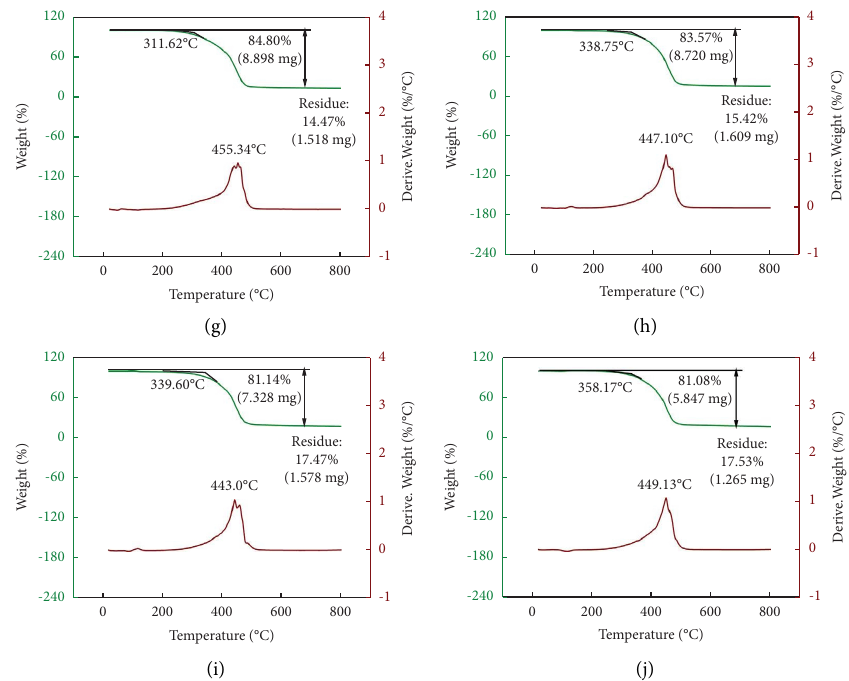
Figure 10: Termogravimetric analysis of matrix asphalt, bio-asphalt, and composite-modifed asphalt: (a) matrix asphalt, (b) Bio-6%, (c) Bio-9%, (d) Bio-12%, (e) Bio-6%, 1% nano-ZnO, (f) Bio-9%, 1% nano-ZnO, (g) Bio-12%, 1% nano-ZnO, (h) Bio-6%, 3% nano-ZnO, (i)